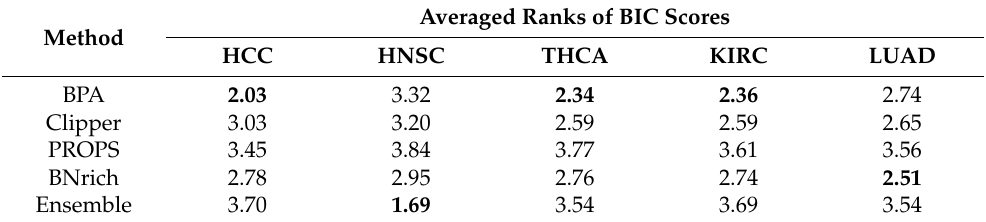
Table 3. Averaged ranks of BIC scores of all pathways by BPA, Clipper, PROPS, BNrich, and Ensemble method across five datasets. Values in bold indicate the best ranked method in specific datasets. Averaged Ranks of BIC Scores Method HCC HNSC THCA KIRC LUAD